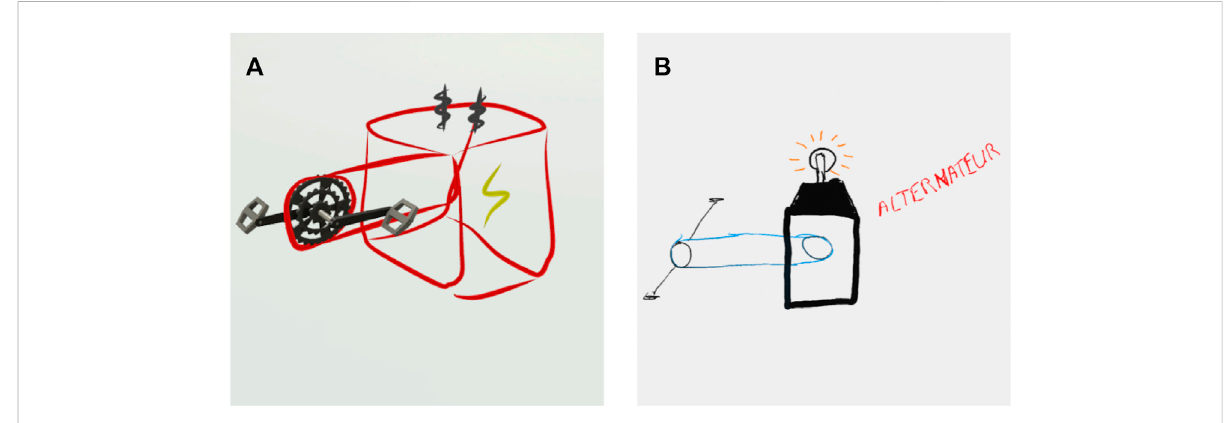
FIGURE 2 Exampleofideasproducedbytwodifferentparticipants: (A) inthevirtualrealityconditionand (B) intheinteractivewhiteboardcondition.Inthis case, both represent electricity-generating machines.